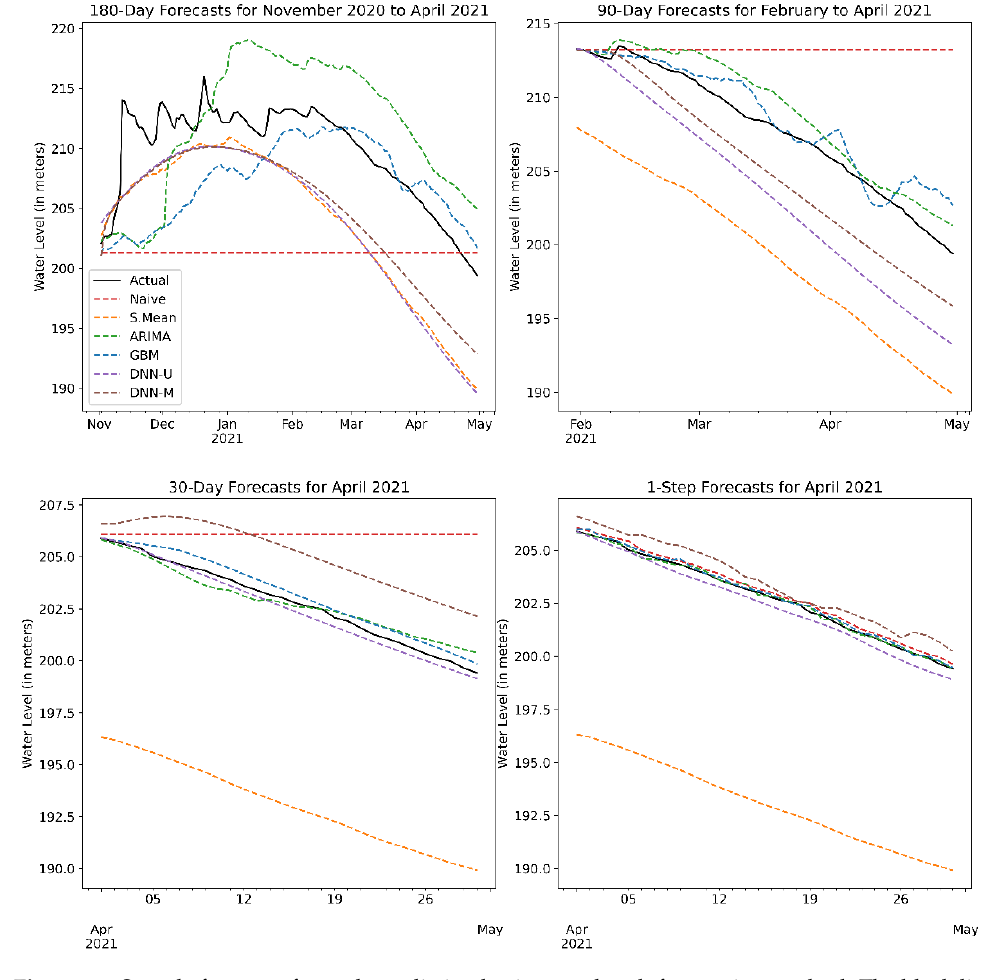
Figure 11. Sample forecasts for each prediction horizon and each forecasting method. The black line depicts the actual observed water level, while the dashed lines indicate the model forecasts. We note that forecasts such as these are generated at each step of TSCV and their error and goodness-of-fit statistics are calculated at each step. As such, we note that these plots do not reflect the average performance of each model.